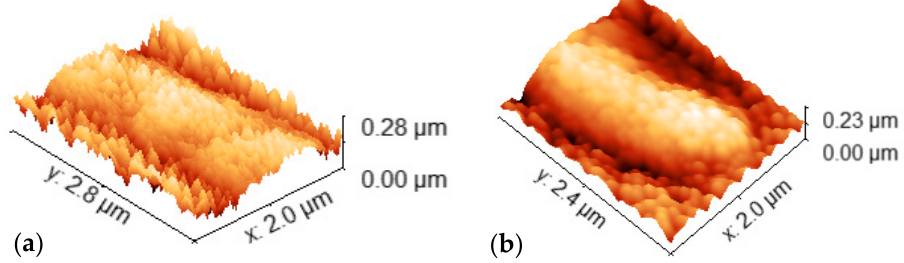
Figure 4. Three-dimensional topographical AFM images of the hillock regions observed in the 1600 nm Cr coatings for: ( a ) PCB and ( b ) PCW.